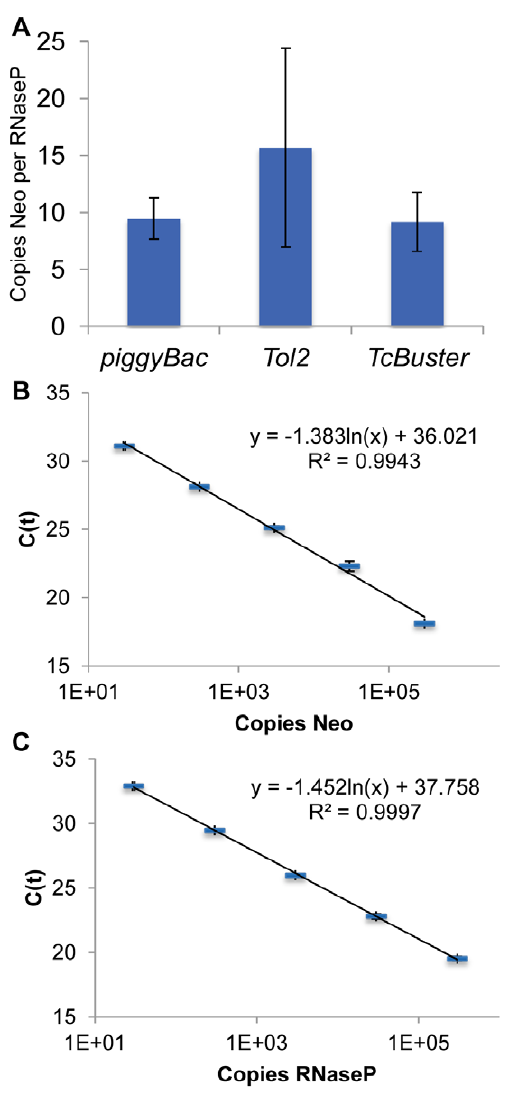
Figure 7. Transposon copy number analysis by real-time quantiative PCR (qPCR) for piggyBac , TcBuster , and Tol2 . ( a ) The number of copies of the transposon ( Neo ) per haploid genome (copy of RNaseP ). There was no statistically significant difference between the transposons by the ANOVA test. Propagation of errors was used to combine errors inherent in the plates per group and replicates per plate. Error bars represent the standard error of the mean. ( b ) Standard curve showing the C(t) result vs number of copies of pTpB added. ( c ) Standard curve showing the C(t) result vs number of copies of pRNaseP added. Both sets of standards were performed in triplicate for each dilution. The equation for the line of best fit and R squared value are printed on each graph. The error bars represent the standard error of the mean. pattern and preference when compared to the other most commonly used systems, Sleeping Beauty and piggyBac . By colony assay, TcBuster was comparable to other transposon systems and displayed a slightly negative dose-response when an excess of addition of TcBuster transposase to the group of enzyme systems available for the permanent addition of genes to mammalian genomes.